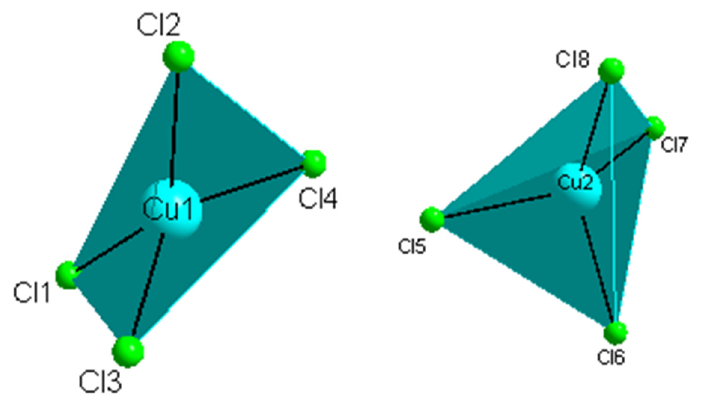
− and [Cu(2)Cl 2 − 4 ]